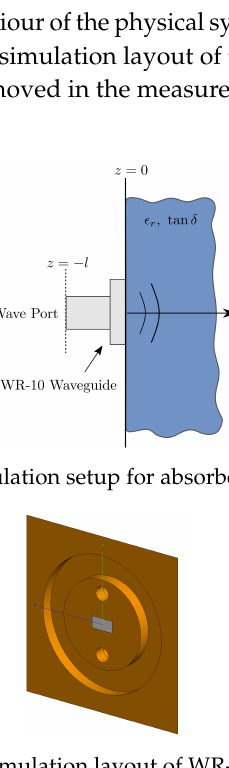
Figure 3. Simulation layout of WR-10